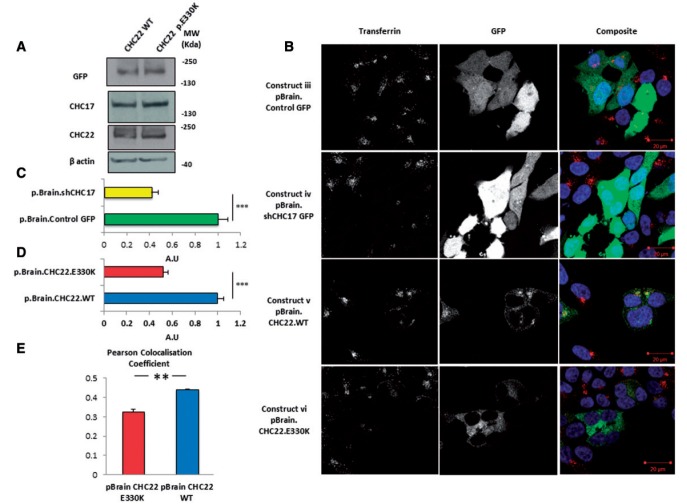
p.E330K in CLTCL1 is a pathogenic mutation. (A) The p.E330K mutation has no effect on the steady state levels of CHC22 or CHC17 in HEK293 cells determined by western blotting. (B) Transferrin internalization assay was used to determine the functionality of the p.E330K mutant in HEK293 cells. Red signal represents transferrin-Alexa Fluor® 546, green indicates GFP or CHC22.GFP, and blue DAPI. (C) Cells transfected with control shRNA and tagged with GFP (construct iii) display normal transferrin internalization, whereas transfection with shRNA against CHC17 (construct iv) significantly inhibited transferrin internalization (P < 0.001). (D) Cells transfected with the same shRNA construct against CHC17 also expressing wild-type CHC22 (construct v) displayed functional transferrin internalization, whereas cells transfected with the same construct except carrying the p.E330K mutation (construct vi) demonstrated no rescue of transferrin internalization (P < 0.001 compared with pBrain.CHC22.WT). (E) There was also a reduced co-localization of CHC22.E330K (construct vi) with fluorescent transferrin compared with CHC22.WT (construct v) tested by Pearson Co-localization Coefficient (P < 0.005). (C) Represents the pooled data from two independent repeats confirming the previously demonstrated effect of CHC17 knock down on transferrin internalization (Esk et al., 2010; Willox and Royle, 2012). At least 58 cells counted for each transfection condition. (D) Represents the pooled data from four independent experiments normalized to pBrain.CHC22.WT. At least 136 cells counted for each transfection. (E) Represents pooled data from three independent experiments. Statistical tests were two-tailed Student’s t-tests. Error bars represent standard error. For explanation of the constructs used in greater detail, see Fig. 2.